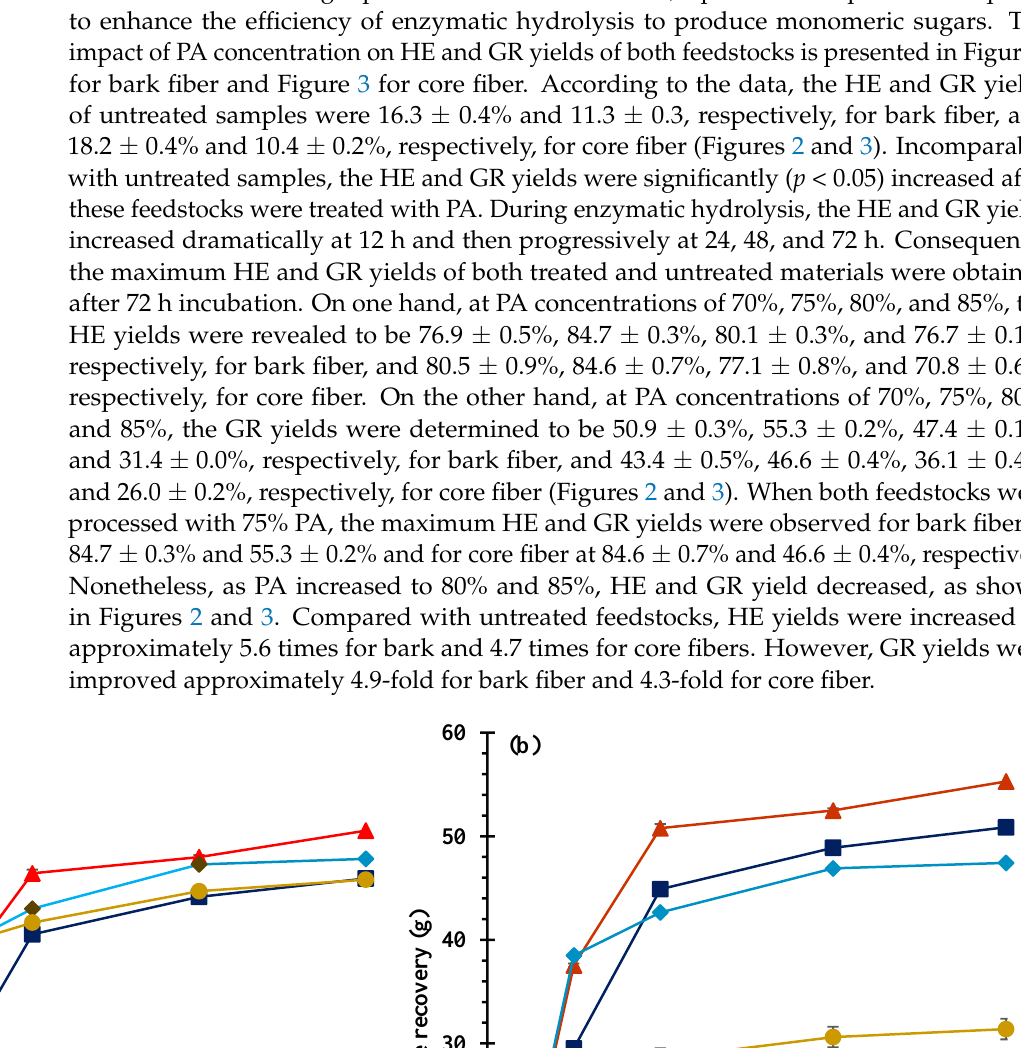
Figure 3. ( a ) Hydrolysis efficiency (HE) and ( b ) Glucose recovery (GR) of core fiber. 3.4. Changes in Surface Morphology Screening electron microscopy (SEM) was used to assess how pretreatment with PA affected the surface morphology of these materials. The surface morphology of both treated and untreated samples could be observed in the SEM micrographs, as shown in